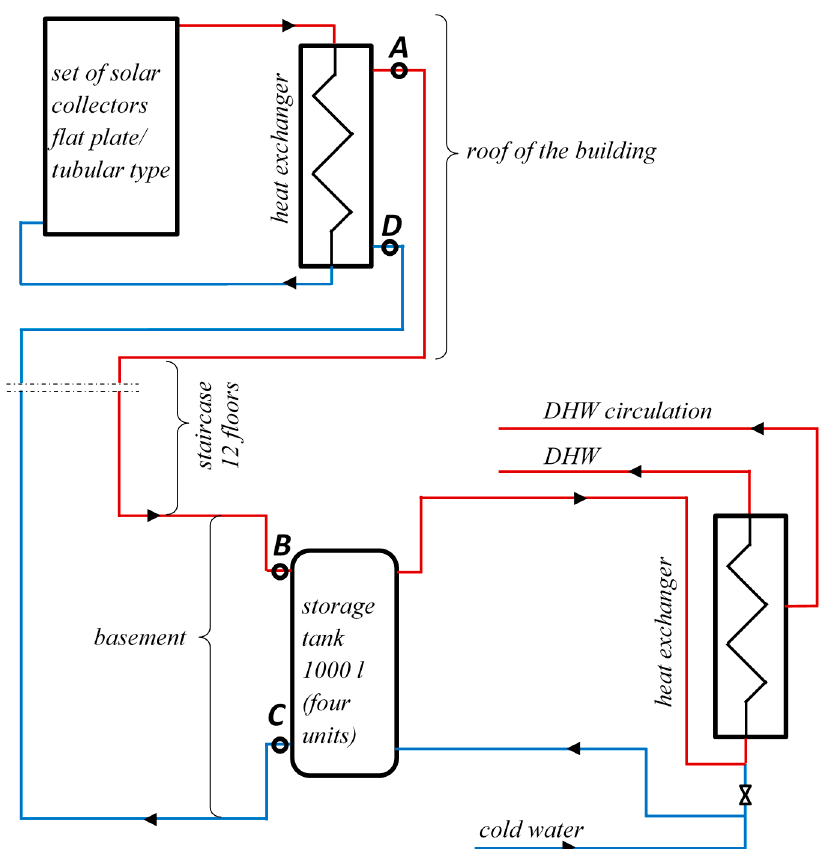
Figure 3. Schematic diagram of the SDHW heating system (the letters A , B , C , D indicate the measuring points).